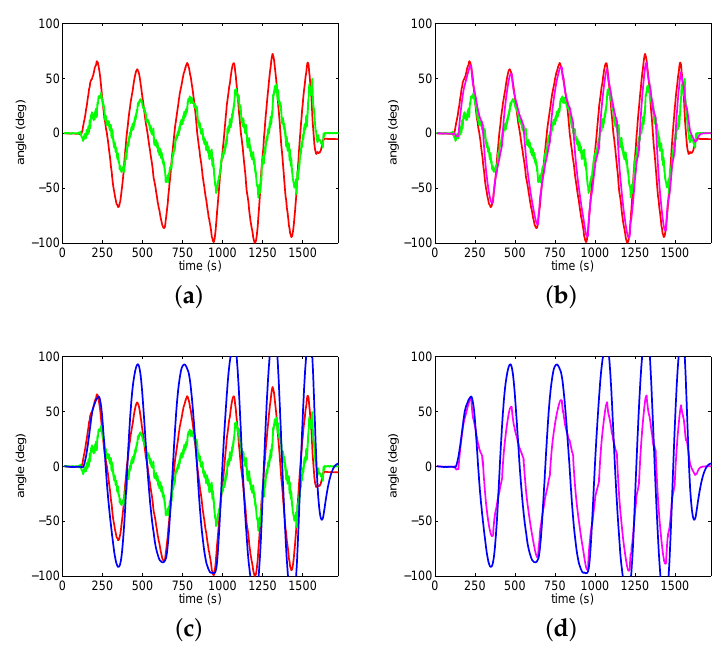
Figure 9. Experiment 2 (Red line is angular output of gyro. Green line is angular output of accelerometer. Carmine line is angular output after compensation. Blue line is angular output after Kalman filter.). ( a ) Angular outputs of gyro/accelerometer; ( b ) Applying the proposed compensation method; ( c ) Applying Kalman filtering method; ( d ) Comparison of two methods.